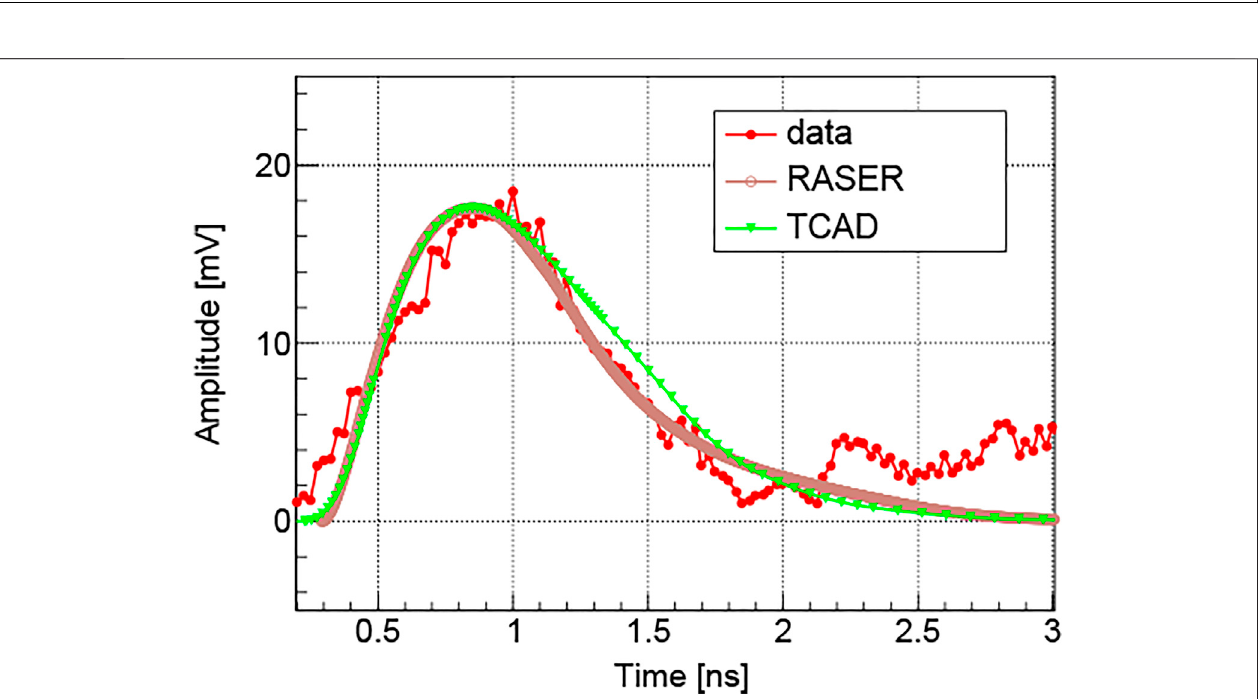
FIGURE 11 | (Color online) Waveform comparison: measured data (brown) and RASER simulation (green).